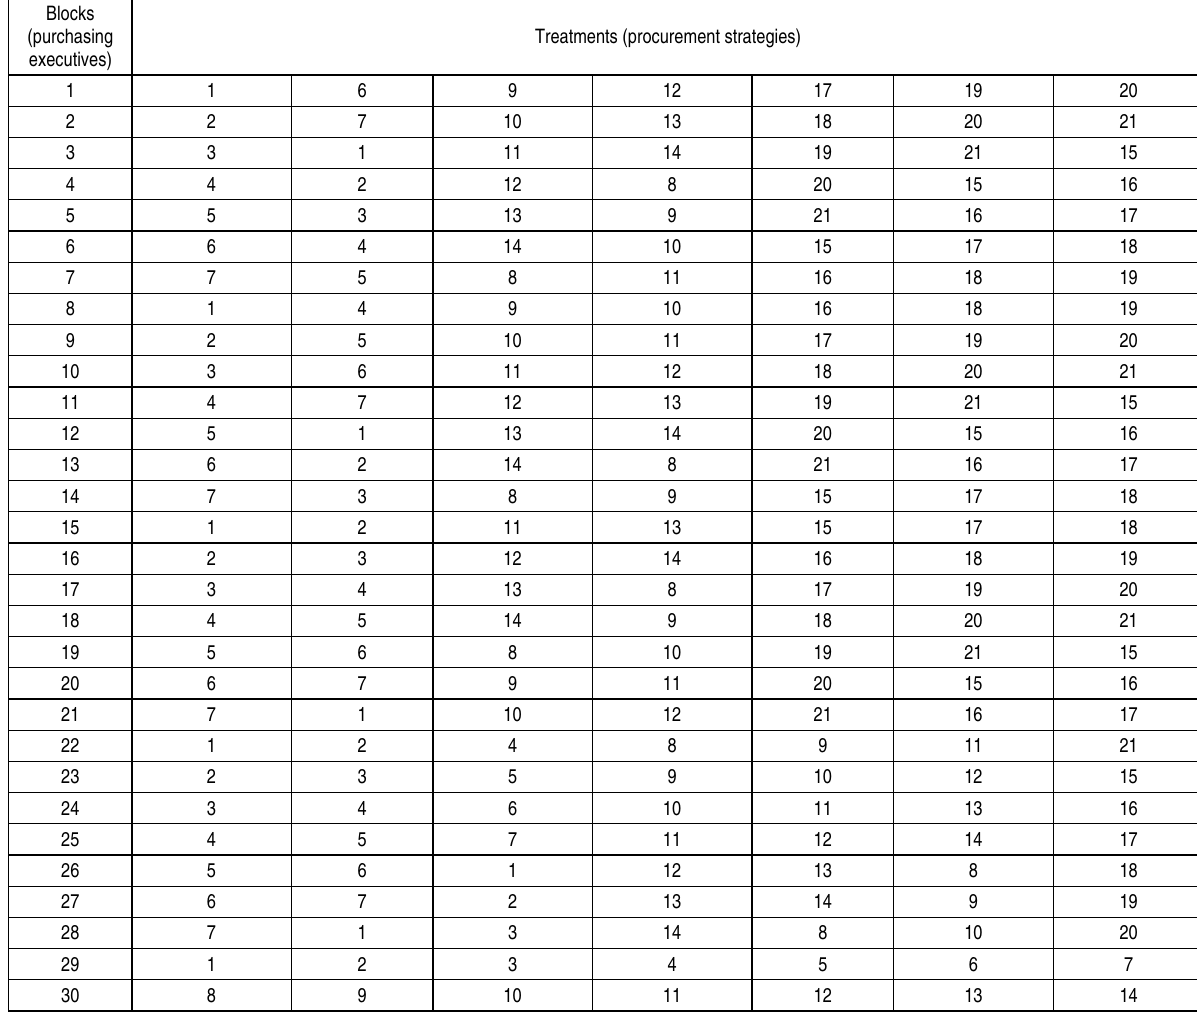
Table 3. General BIBD for procurement strategies in each product life cycle